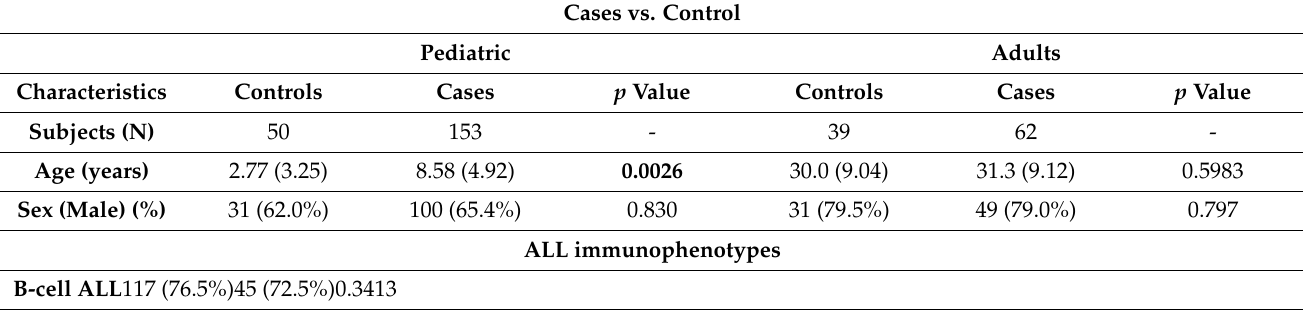
Table 1. Demographic data of control and cases.